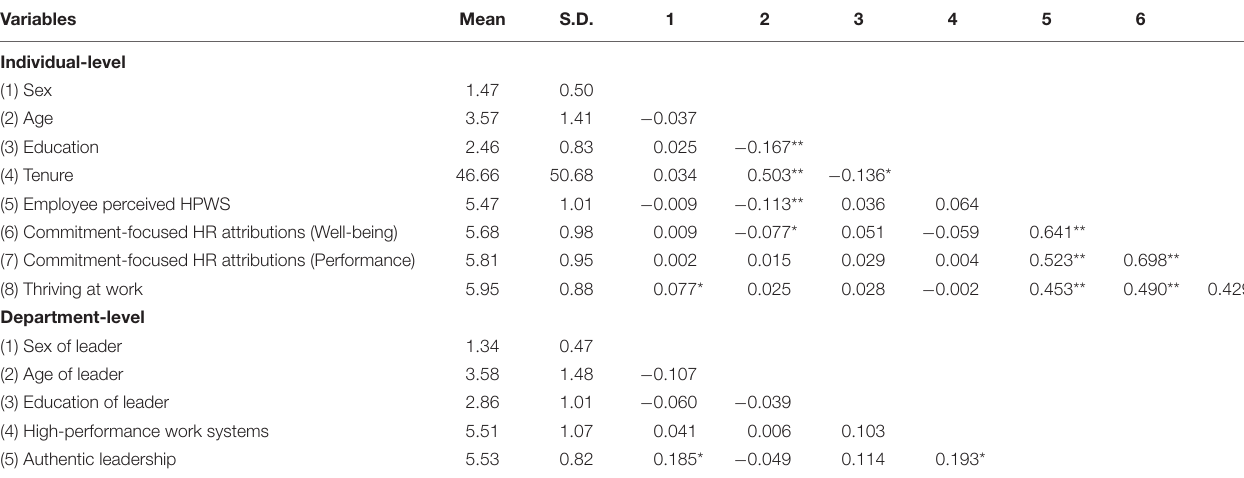
TABLE 1 | Descriptive statistics and